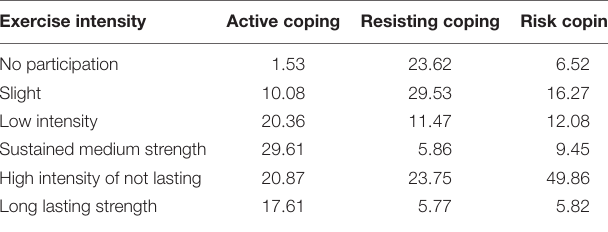
TABLE 1 | Correlation between the physical exercise coping behaviors and exercise intensity of college students. Exercise